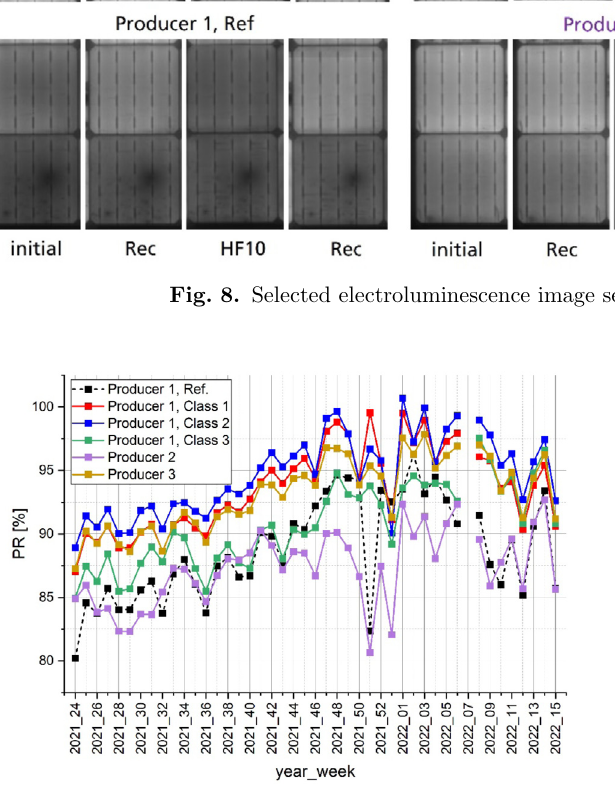
Fig. 9. Weekly performance ratio (PR) of the different strings per group for the period from week 24 of 2021 to week 15 of 2022; there are problems with data availability in calendar week 51 in 2021 (2021_51); for week 7 in 2022 (2022_07) there are no data shown due to deinstallation of the modules for indoor